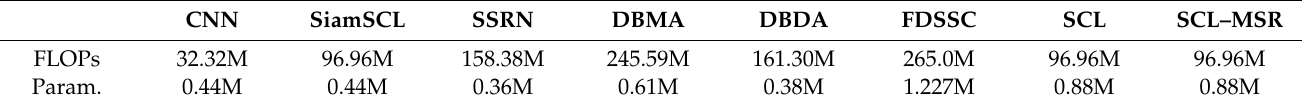
Table 12. The number of FLOPs and